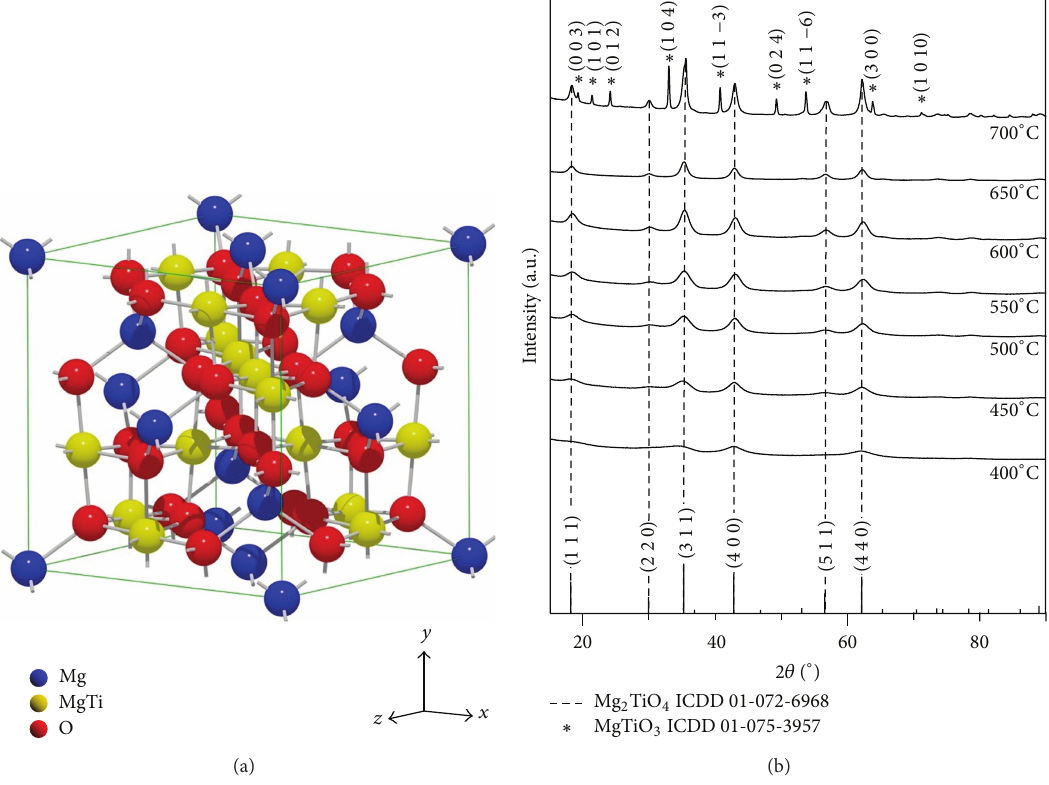
Figure 1: Crystal structure of Eu 3+ activated Mg 2 TiO 4 : (a) schematic of the unit cell; (b) X-ray diffraction patterns of nanoparticles prepared at different temperatures from 400 ∘ C to 700 ∘